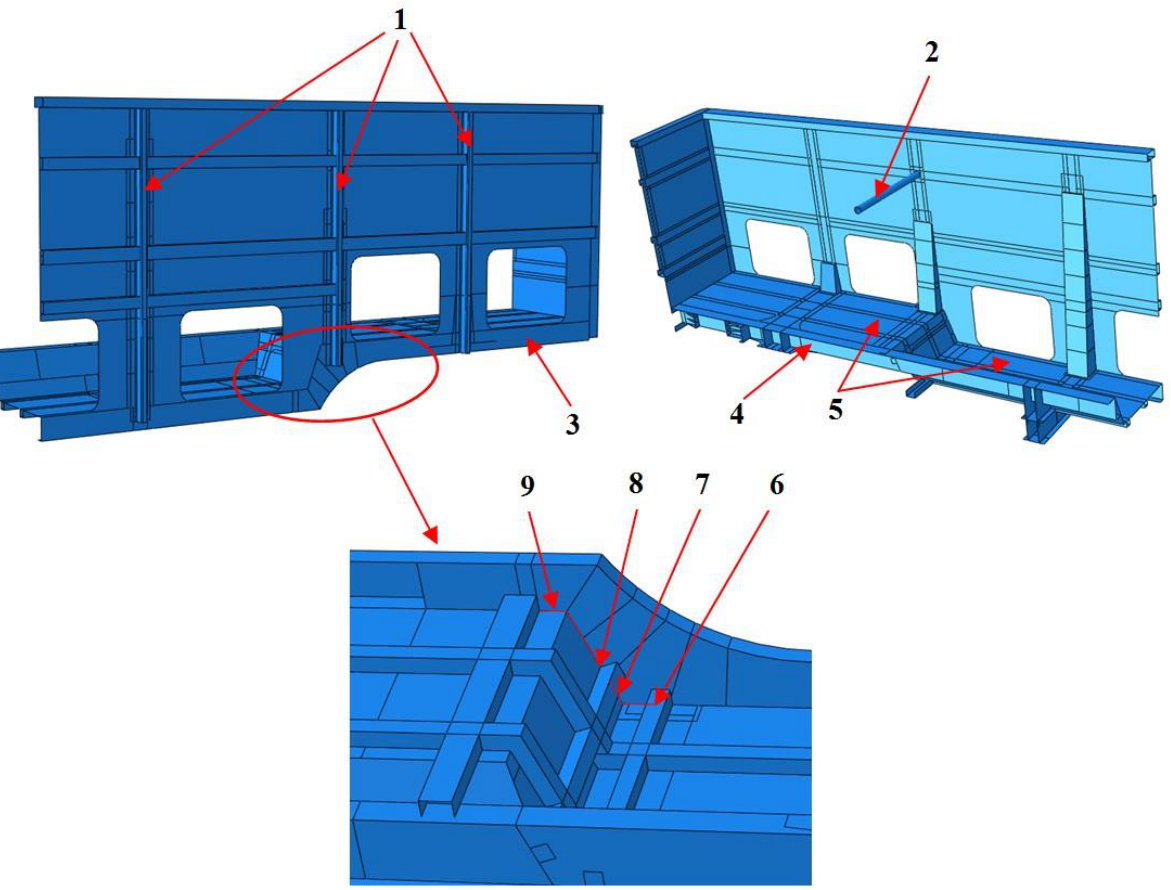
Figure 5. The structure of an 80t depressed-center gondola car body (scheme 2): 1. side post, 2. supporting bar, 3. side sill, 4. center sill, 5. Floor, 6. the starting point of weld 1, 7. weld 1, 8. the starting point of weld 2, 9. weld 2.